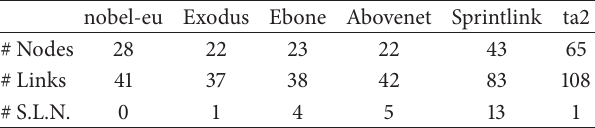
Table 1: Statistics of the network